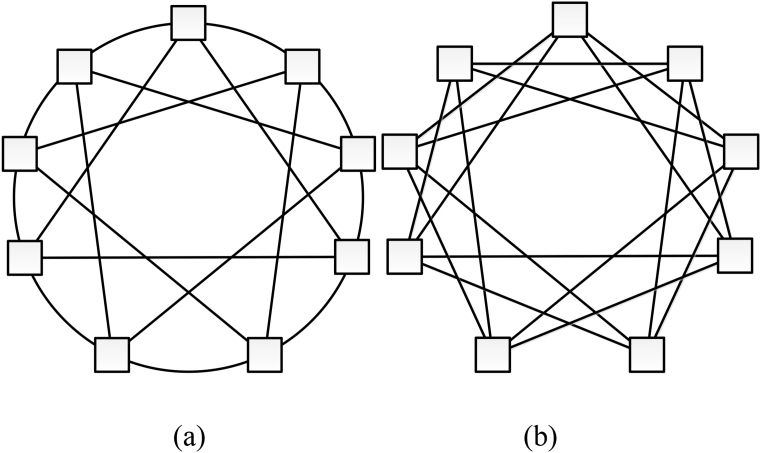
Circulant topology: (а) – C(9;1,3); (b) – C(9;2,3).